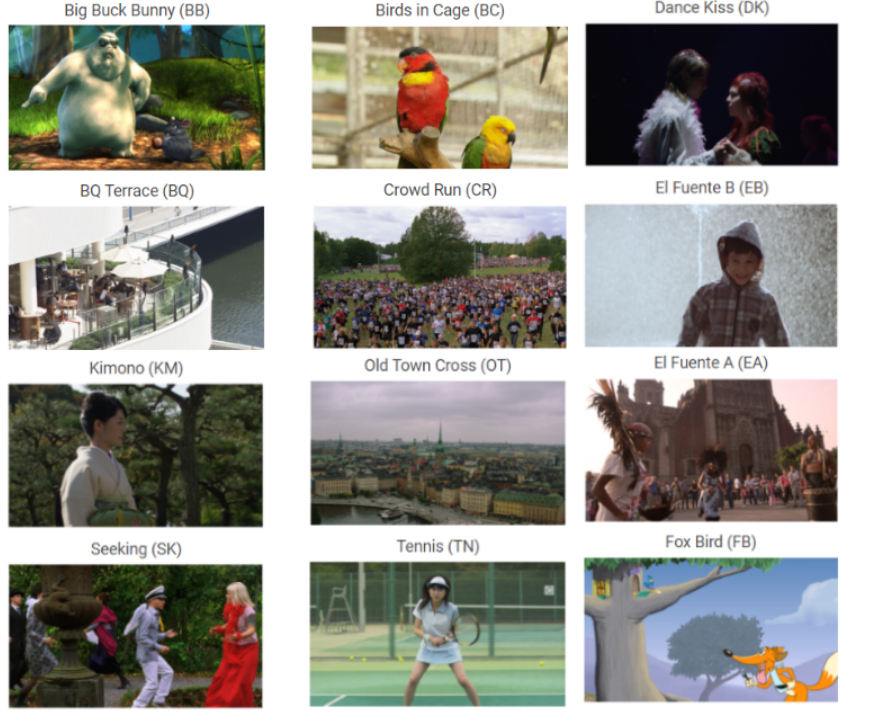
Figure 6. Snapshots from the MCL-V